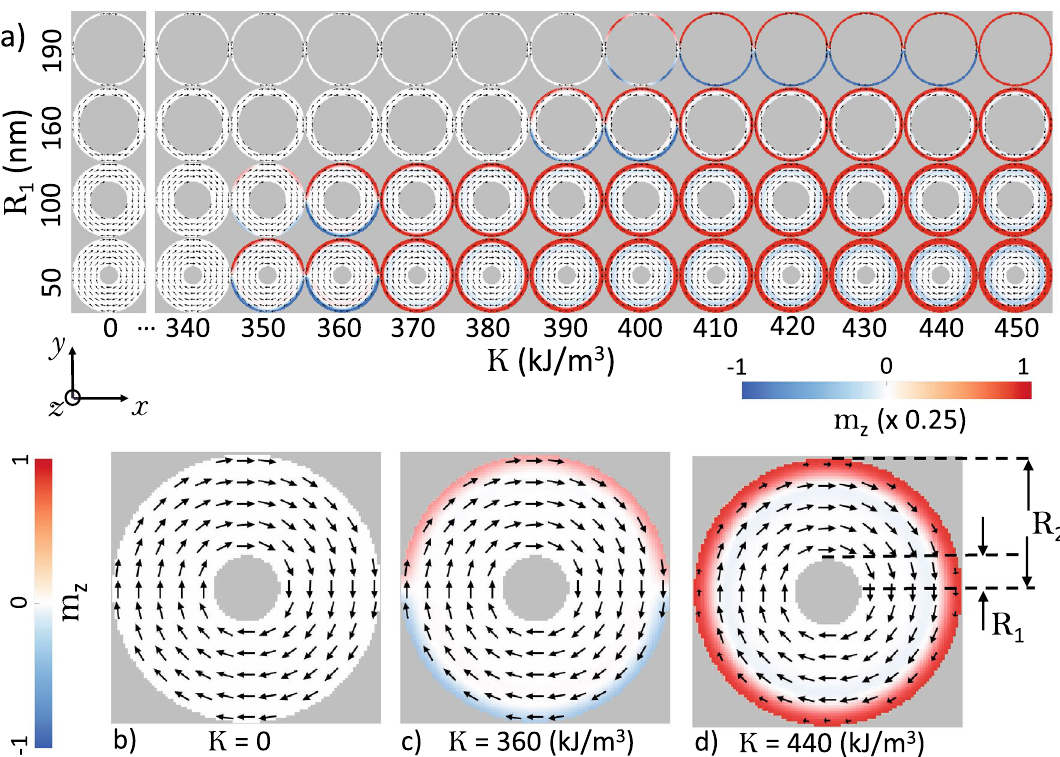
Figure 1. ( a ) Magnetic ground states for the magnetic nanoring for different values of the RPMA strength K and for different values of the ring internal radius (for a visual purpose the color scale for m z was rescaled by a factor 0.25). Typical magnetic states for a wide ring ( R 1 = 50nm ), ( b ) a vortex state, ( c ) a knot state and ( d ) a meron state. In ( b – d ) the color scale for m z was not